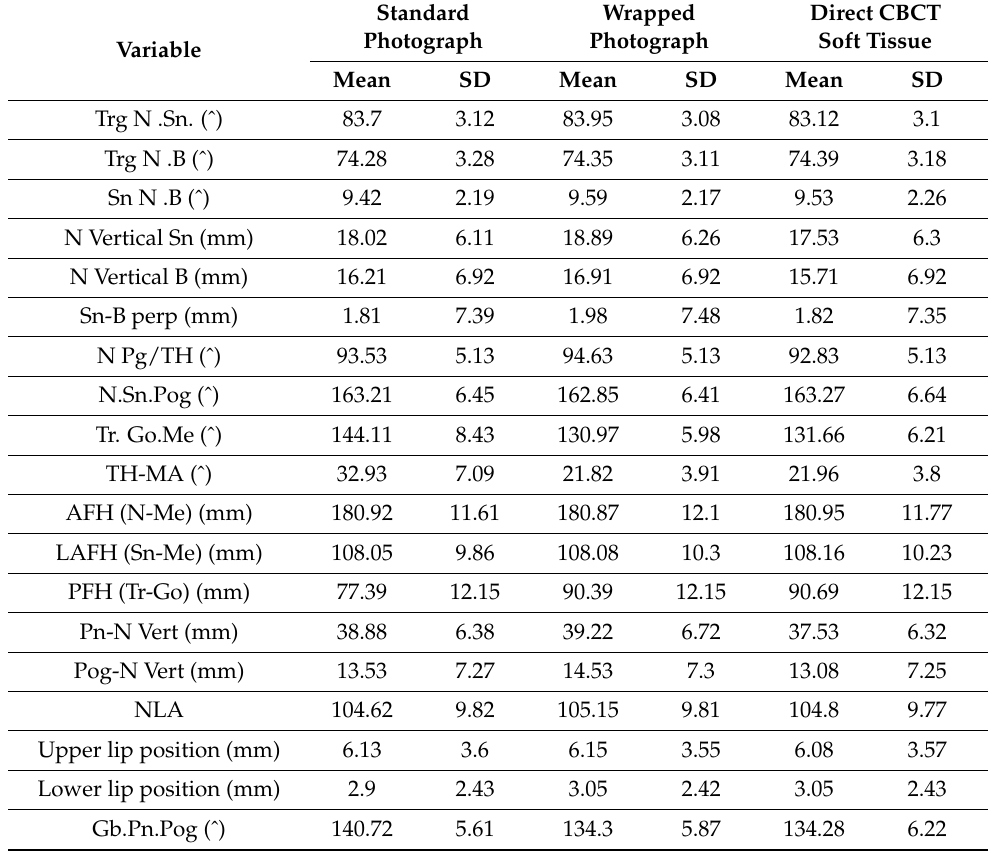
Table 2. Descriptive statistics (means and standard deviations (SD)) of the different variables mea- sured by the standard photograph, wrapped photograph, and direct CBCT soft tissue. Standard Variable